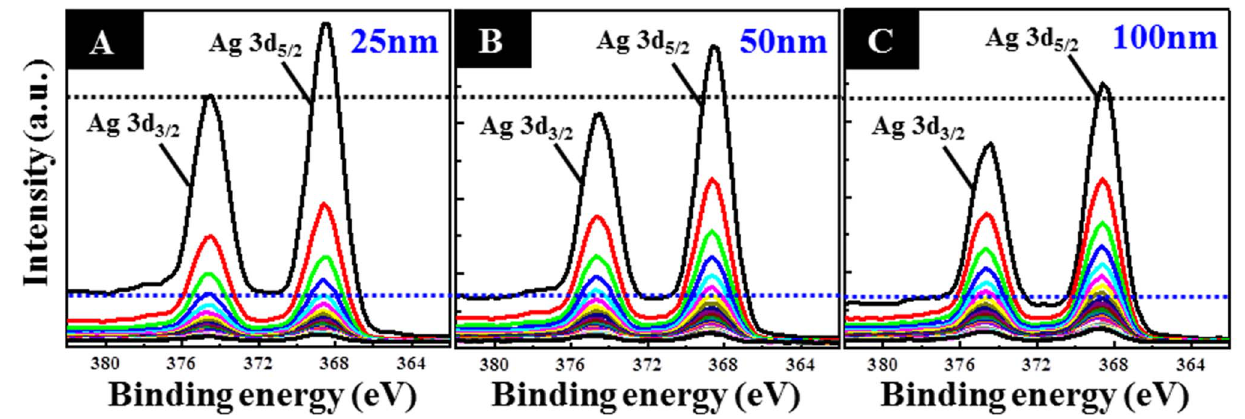
Figure 3. High-resolution XPS spectra in terms of Ag 3d at different depths. For the Ag-decorated TiO 2 nanotubes with the diameters of ( A ) 25, ( B ) 50, and ( C ) 100 nm.